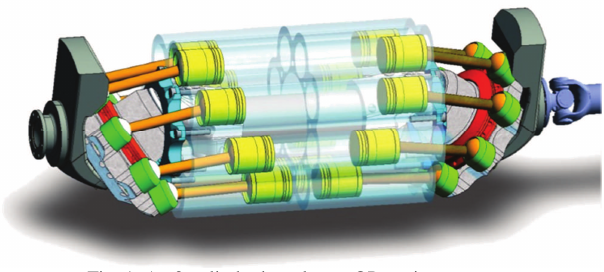
Fig. 1. An 8-cylinder barrel-type OP engine